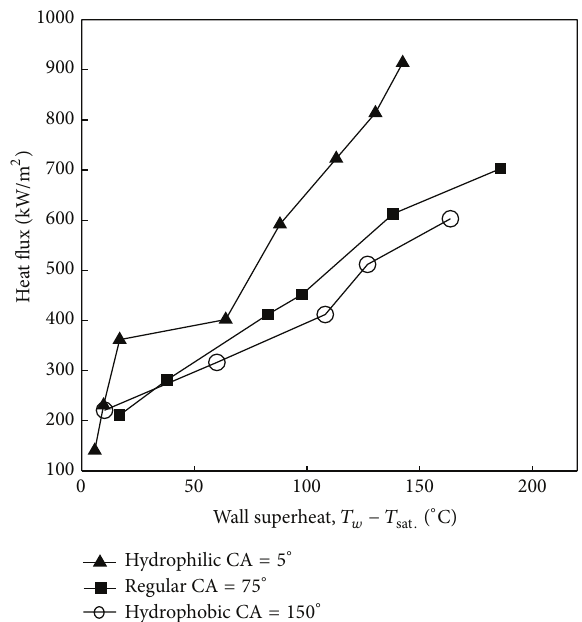
Figure 7: Wall superheat and heat flux plots for different wettability surfaces.